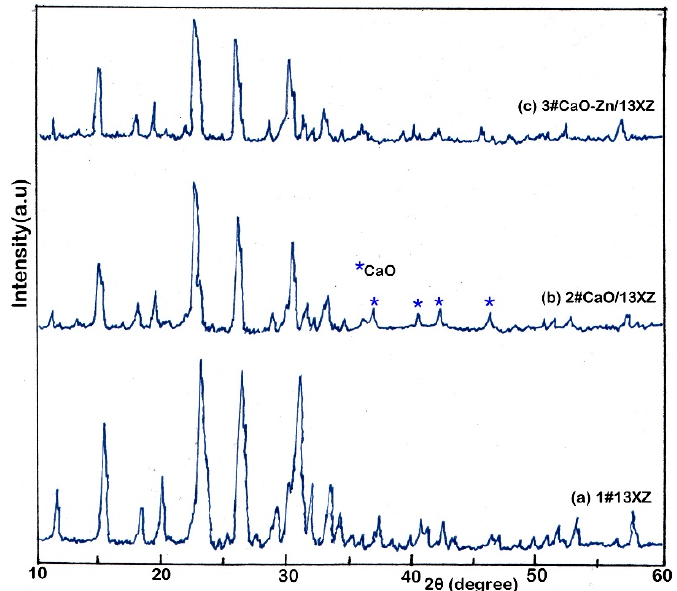
Figure 7. XRD spectra of: 1# 13XZ nanomaterial ( a ), 2# CaO/13XZ nanocomposite ( b ) and 3# CaO-Zn/13XZ nanocomposite ( c ); * CaO-the peak confirms the presence of CaO in zeolite mass.